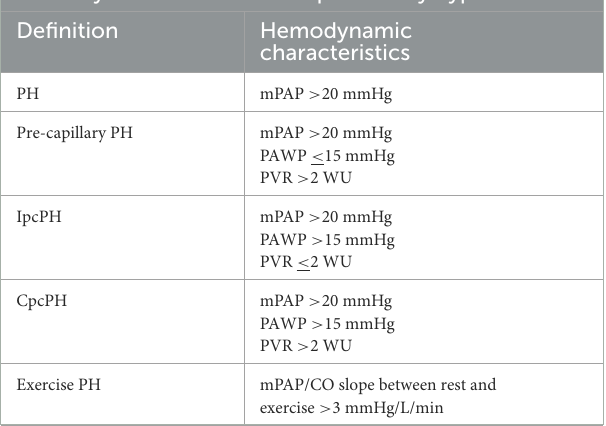
TABLE 4 Comparison of American College of Cardiology (ACC)/American Heart Association (AHA) Stages and New York Heart Association (NYHA) functional classifications based on patient symptoms and objective assessment (29,